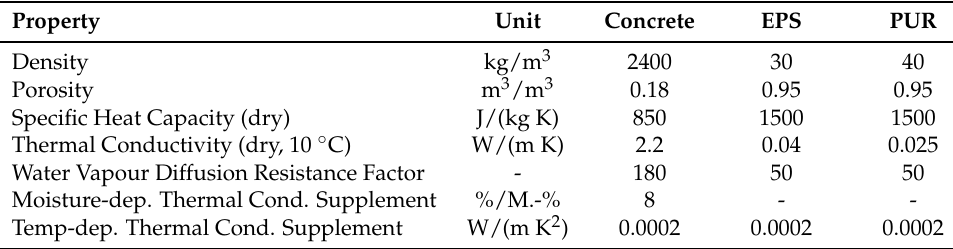
Table 1. Material properties used in thermal analysis.